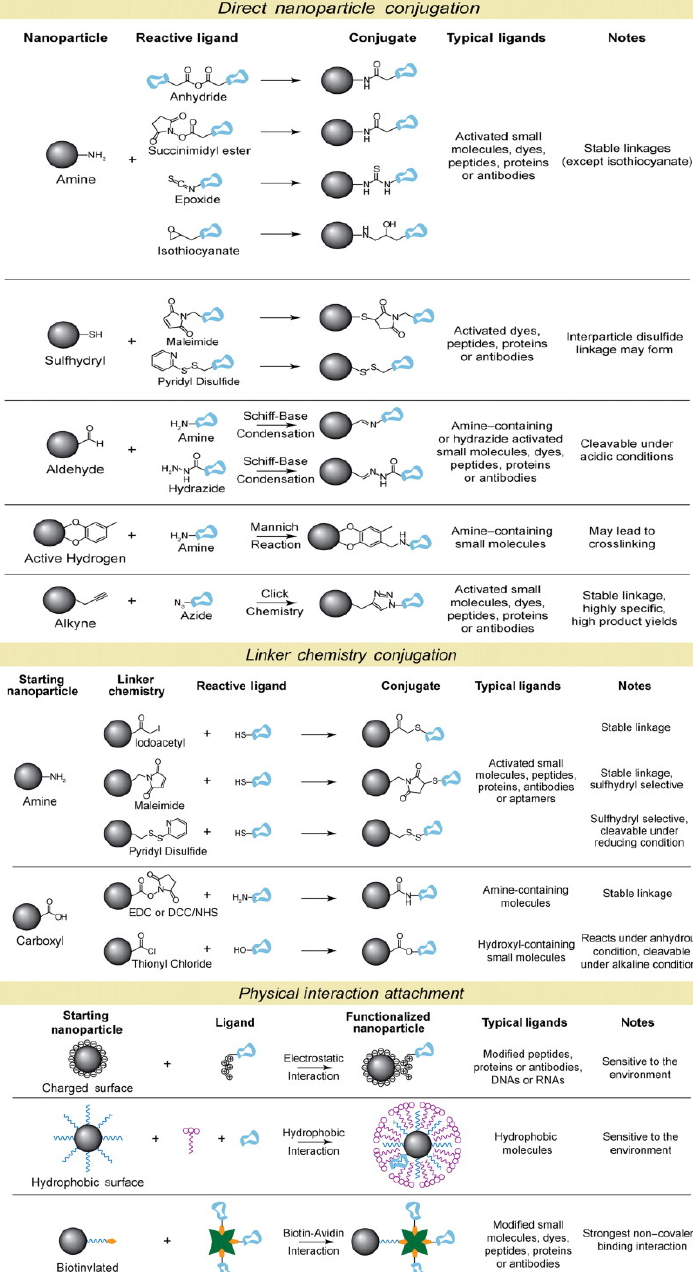
Figure 3. List of SPIONs surface functionalization possibilities. Reprinted with permission from ref. [179]; Veiseh et al., Adv. Drug Del. Rev. 62 (2010) 284–304. Copyright (2009) Elsevier.